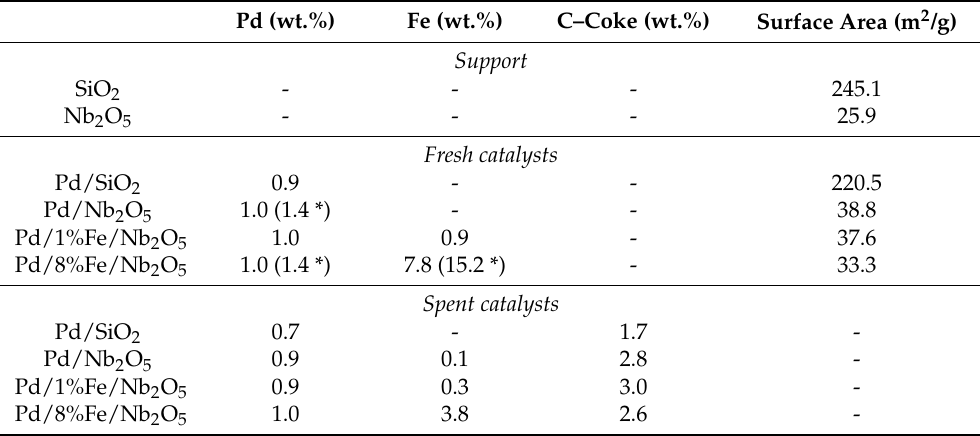
Table 4. Properties of the supports, fresh catalysts and spent catalysts. Pd